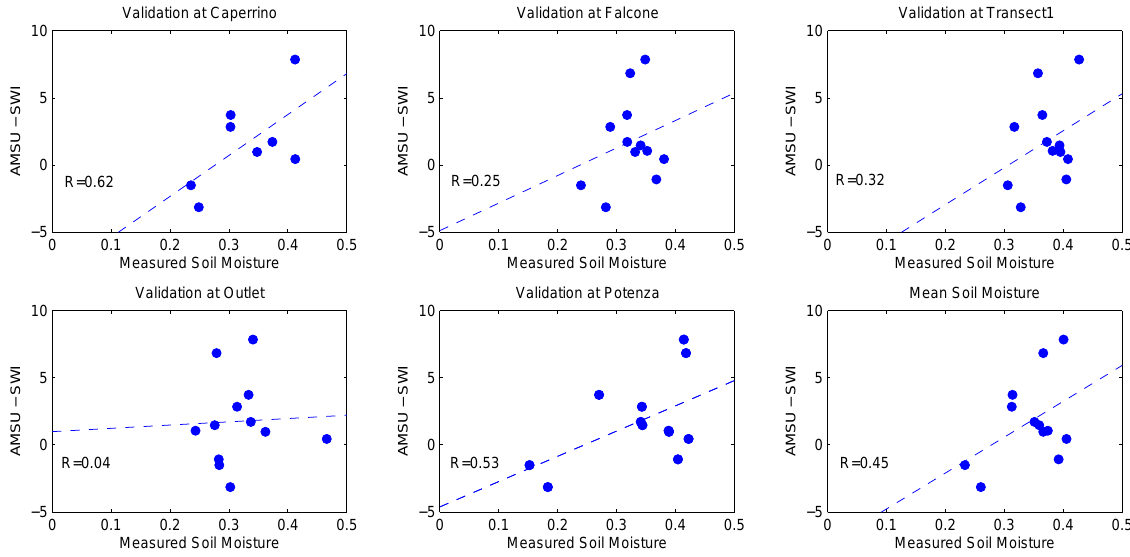
Fig. 2. Comparison between in situ SM (m 3 m − 3 ) measured by TDR and the AMSU SWI (K) at the five sites studied herein and also with the mean value of SM obtained excluding the site at the outlet. The correlation in case is given in the panel in order to provide a better description of the coherence between the two